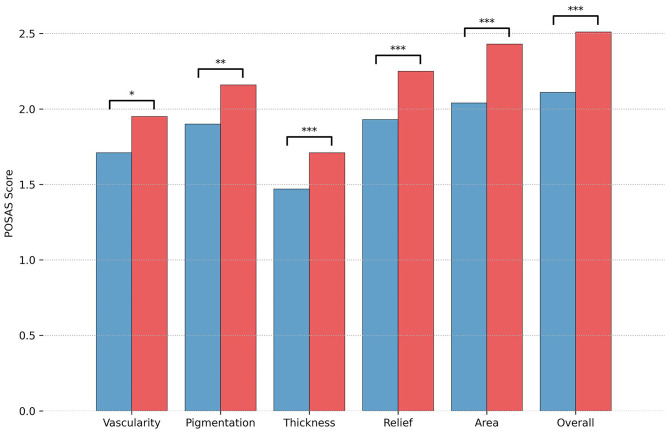
Results of the online evaluation of 230 scars by independent surgeons for mean modified Observer score of the Patient and Observer Scar Assessment Scale (POSAS) are illustrated separately by treatment group (blue = group 1, tissue adhesive, red = group 2, suture). Significance levels are indicated. Significance levels are indicated (*p < 0.05, **p < 0.01, ***p < 0.001).